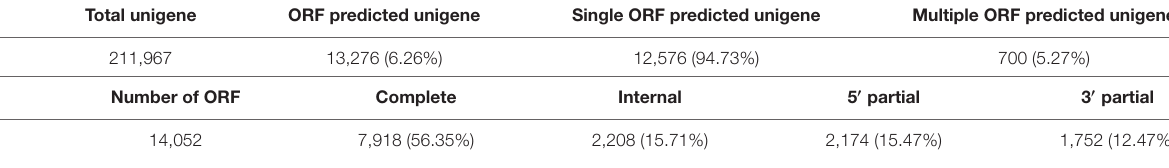
TABLE 2 | Statistics of open reading frame (ORF) prediction.